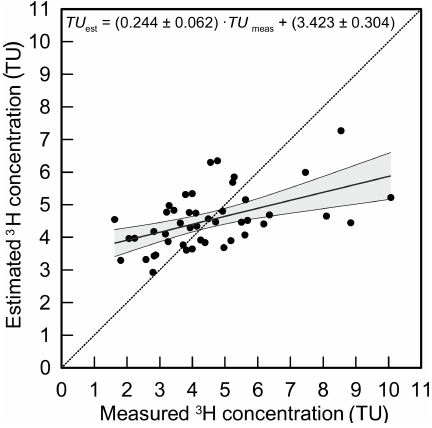
Figure 5. Comparison between the calculated tritium concentra- tions after Eq. (1) and the measured tritium concentrations based on 10d trajectories. The dotted line is the 1 : 1 line; the solid line is the linear regression through the data points with the gray band showing the 95% confidence interval.